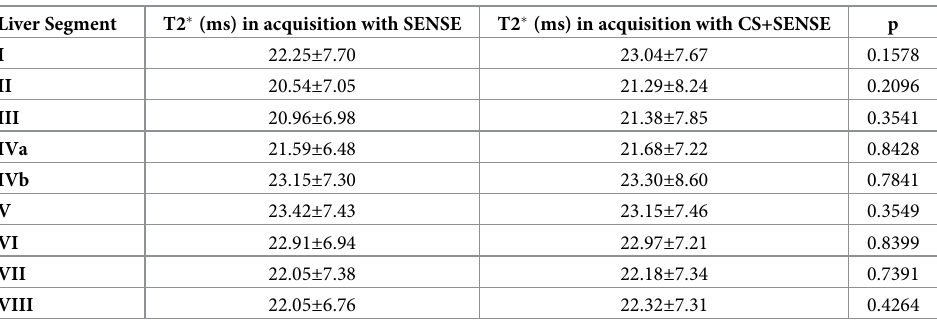
T2 � mean values in ms with standard deviation no significant differences were seen between the two acquisitions. Paired t test (normal distribution); Patients: n =